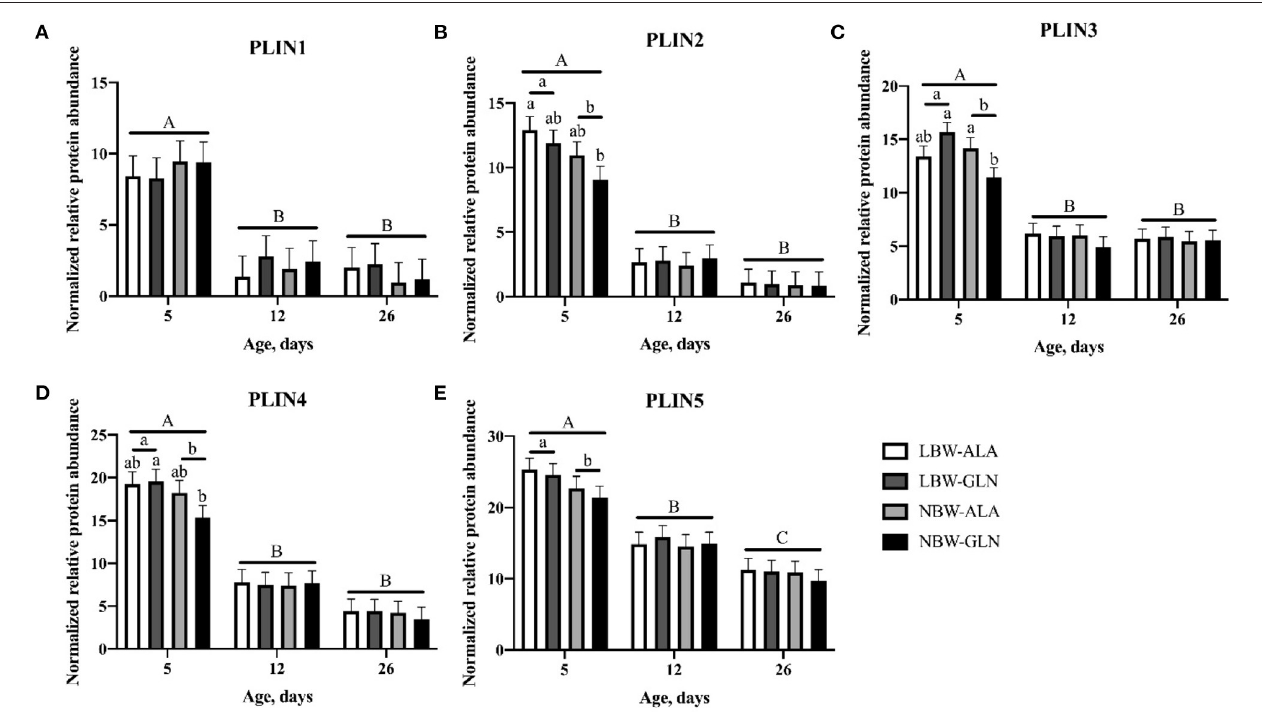
FIGURE 5 | Normalized relative protein abundance of PLIN1 (A) , PLIN2 (B) , PLIN3 (C) , PLIN4 (D) , and PLIN5 (E) in M. longissimus of low- (LBW) and normal-birth-weight (NBW) piglets at 5, 12, and 26 dpn, supplemented with glutamine (GLN) or alanine (ALA) ( n = 12 per group). Values represent LSmeans and SE in error bars of protein abundances normalized to total protein. a,b Significant differences between piglets at the same age; A − C Significant differences among ages ( p < 0.05, Tukey–Kramer